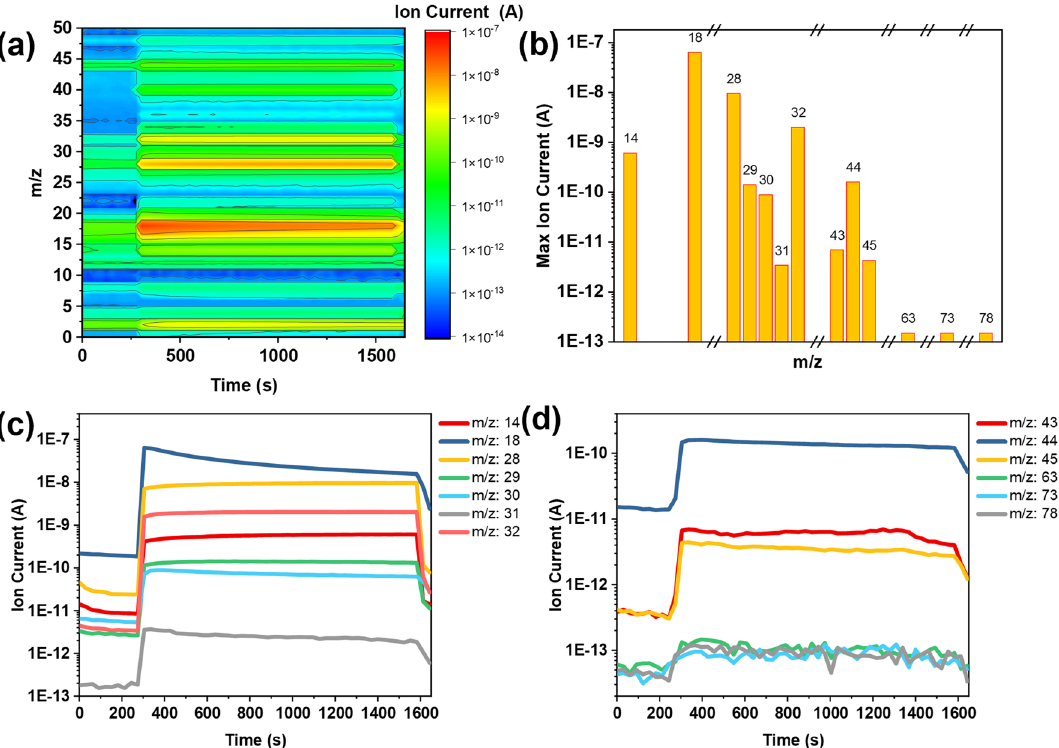
Figure 7. ( a ) Color-coded 3D plot showing the intensity of each m/z over time. ( b ) Histogram plot showing the absolute maximum intensity of m/z values of interest. ( c , d ) Intensities of selected m/z signals over the experiment time. Around t = 300 s the valve was opened leading the gas flow to the detector.